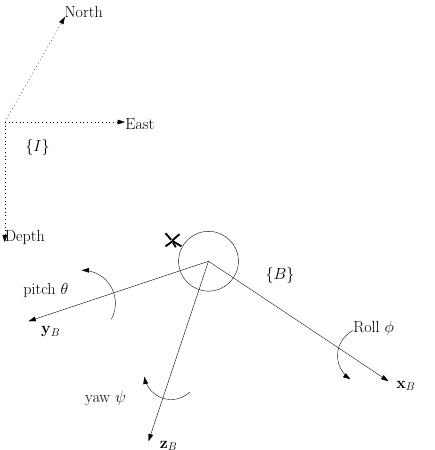
Figure 1. This figure depicts three euler angles ( φ , θ , and ψ ). In this figure, there is a spherical UUV, and we plot a cross-shaped propeller at the back of the UUV. Furthermore, this figure depicts the inertial reference frame